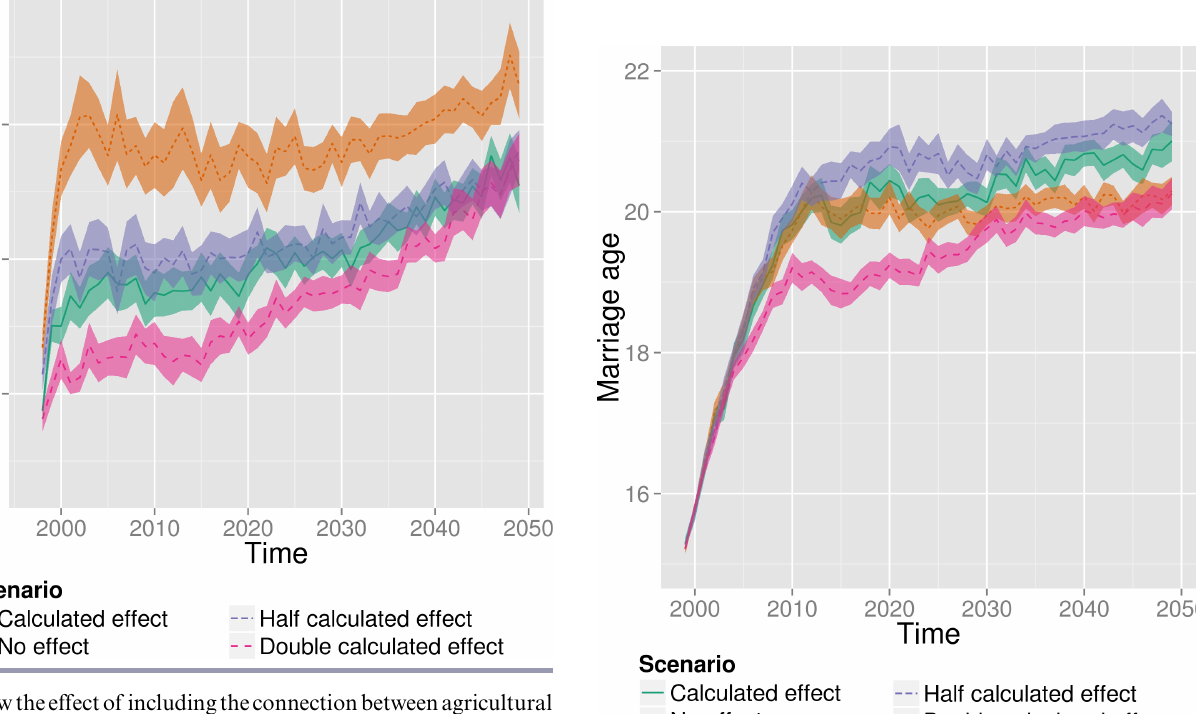
Fig. 5 . Mean marriage age for women in predominantly agricultural neighborhoods, plotted for the four scenarios in scenario set